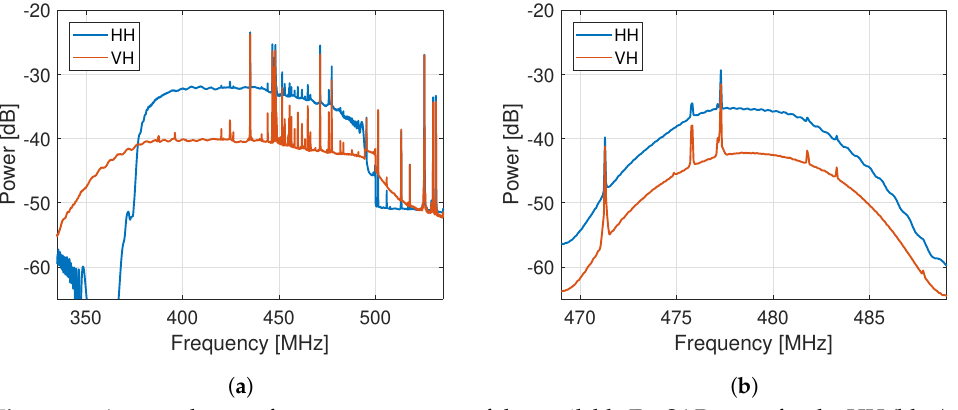
Figure 35. Averaged range-frequency spectrum of the available EcoSAR scene for the HH (blue) and VH (orange) image: ( a ) Entire recorded spectrum with cut-off chirp due to too short receive window; ( b ) Spectrum after hamming window is applied to keep common spectrum only.